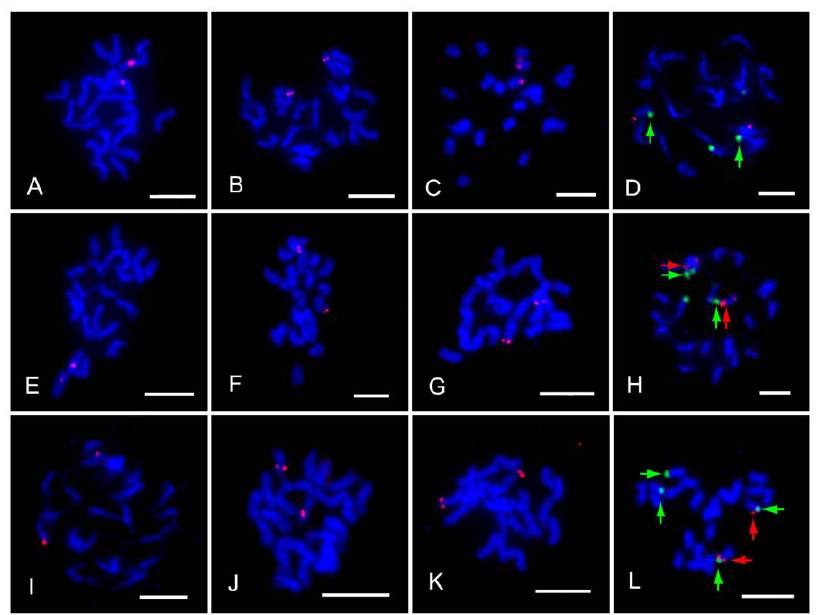
Figure 5. Assignment of linkage groups to eleven chromosomes. Arrowheads are locations of 45S (green) and 5S (red) rDNA sites in photographs D, H and L. Red signals are locations of BACs on each chromosome and 5S rDNA on chromosome 8. (A) to (C) Hybridization of BAC clones 10K19, 60M17 and 51B14 on chromosome 1, 2 and 3, respectively. (D) Hybridization of BAC clone 51N03 (red) and 45S rDNA (green) on chromosome 4. (E) to (G) Hybridization of BAC clones 109C21, 10M24 and 51P08 on chromosome 5, 6 and 7, respectively. (H) Hybridization of BAC clone 51F09 (red) and 5S rDNA (red arrowheads) and 45S rDNA (green arrowheads) on chromosome 8. (I) to (K) Hybridization of BAC clones 51A03, 36G07, 50J01 on chromosome 9, 10 and 11, respectively. (L) FISH pattern on the prometaphase chromosomes using both 5S (red) and 45S rDNA (green) probes. Scale bar=5 m m.